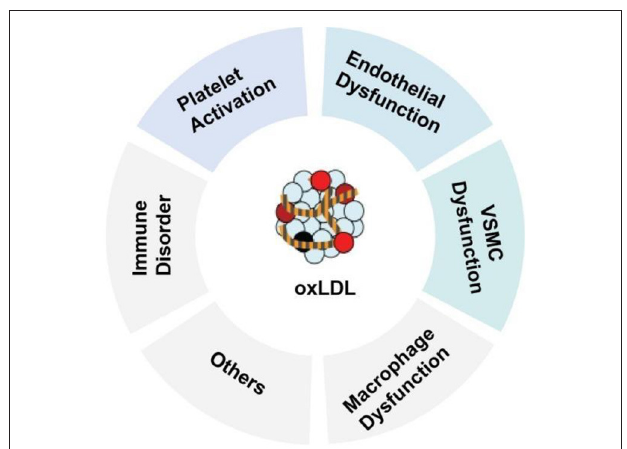
FIGURE 1 | Role of oxidized LDL (oxLDL) in